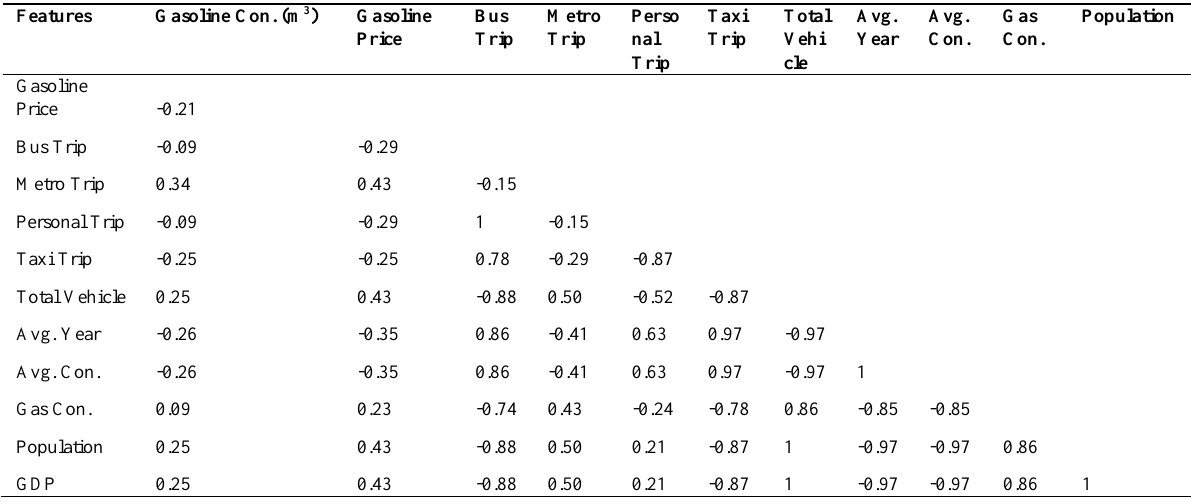
Table 12. Spearman’s correlation coefficient after